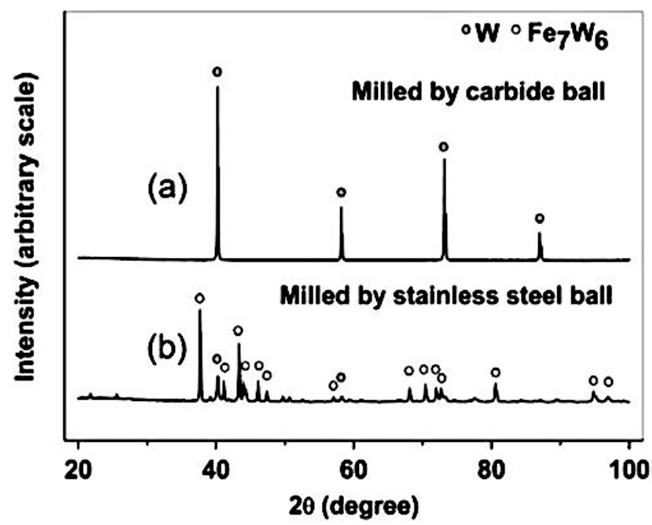
Figure 6. XRD profiles of tungsten by MW process [38].